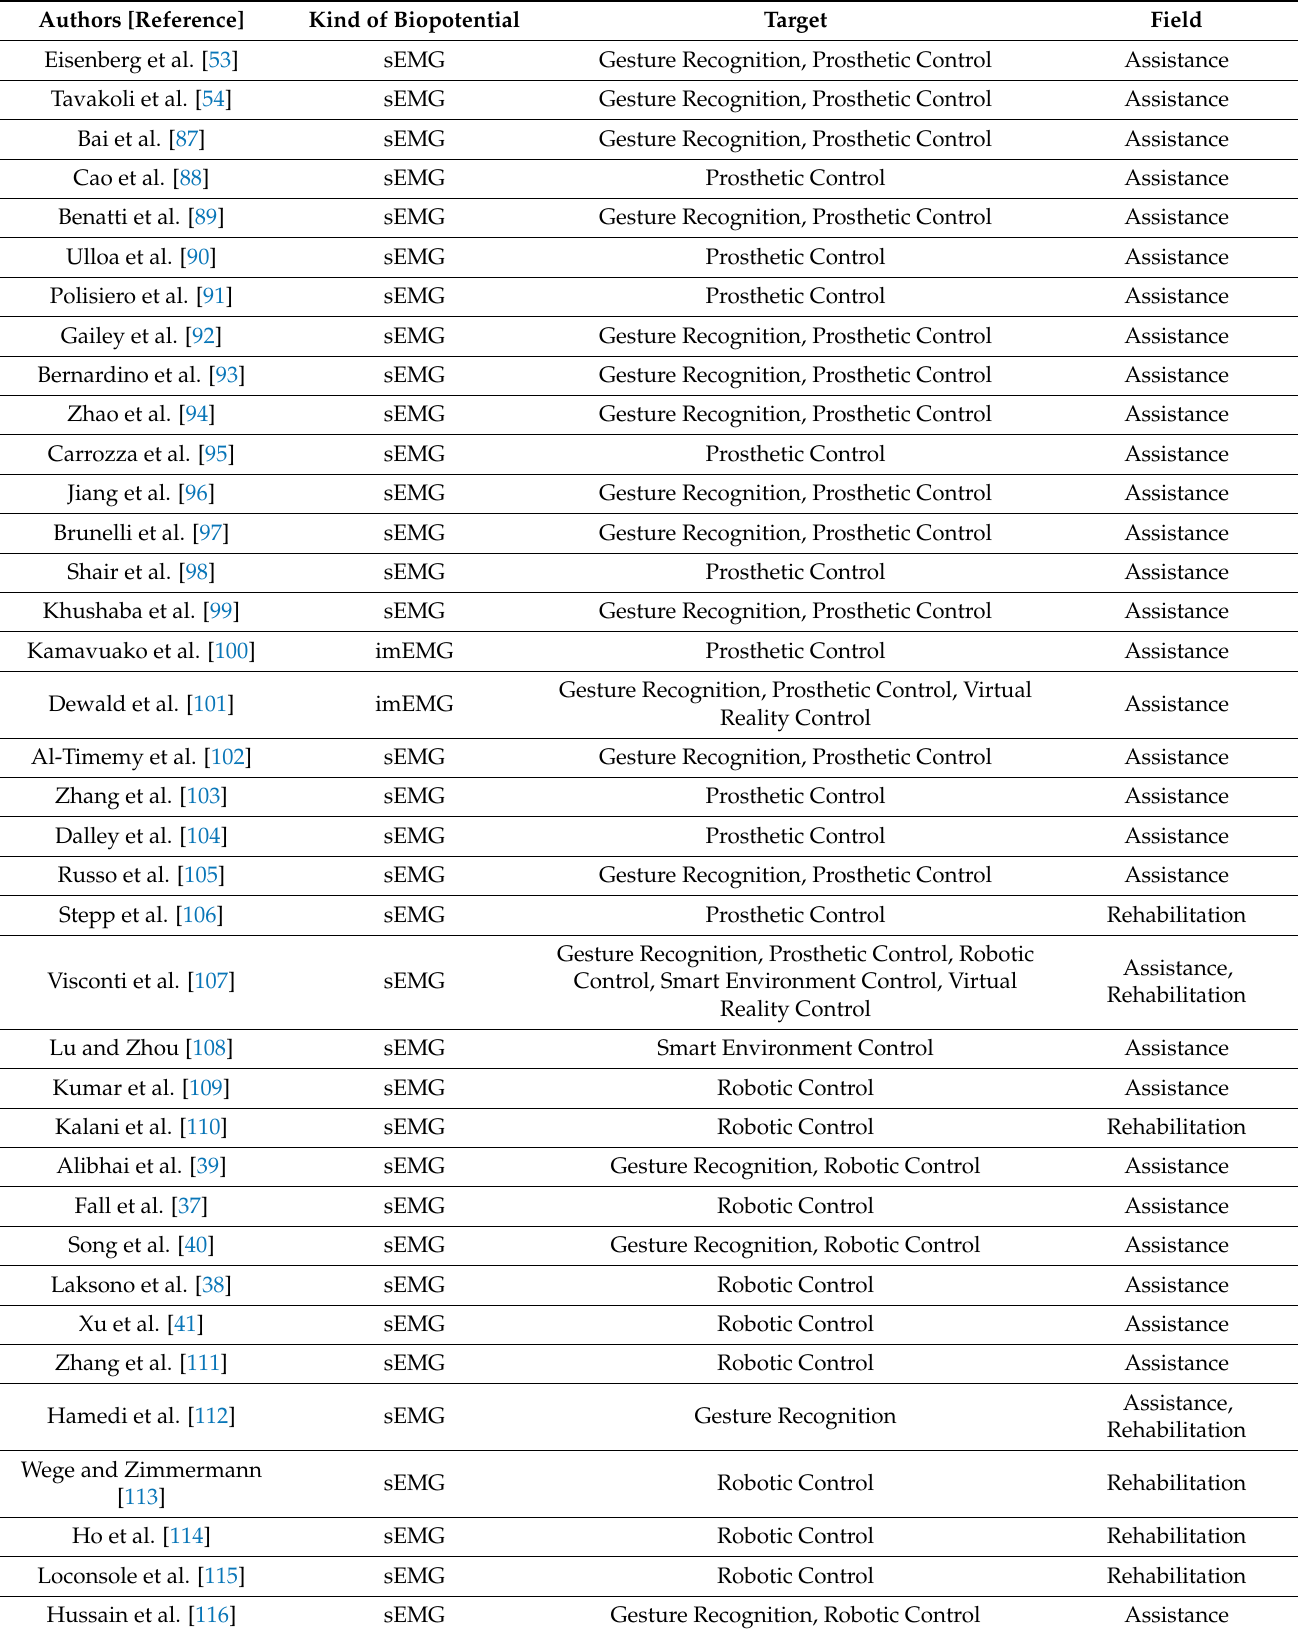
Table 3. EMG-based